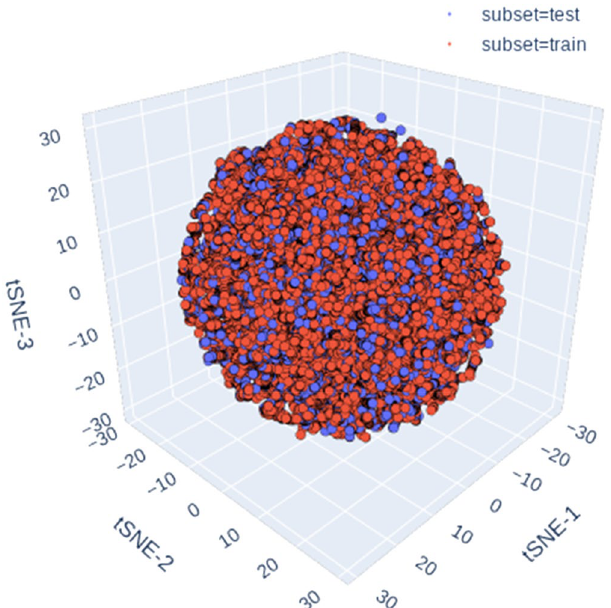
Figure 1. A 3D scatter plot of the three t-SNE axes projected over the RDKit-descriptors space. Data points are colored according to the belonginess of the data point to either the training or test dataset. The figure was generated with Python Matplotlib 3.2.1: https:// matpl otlib.